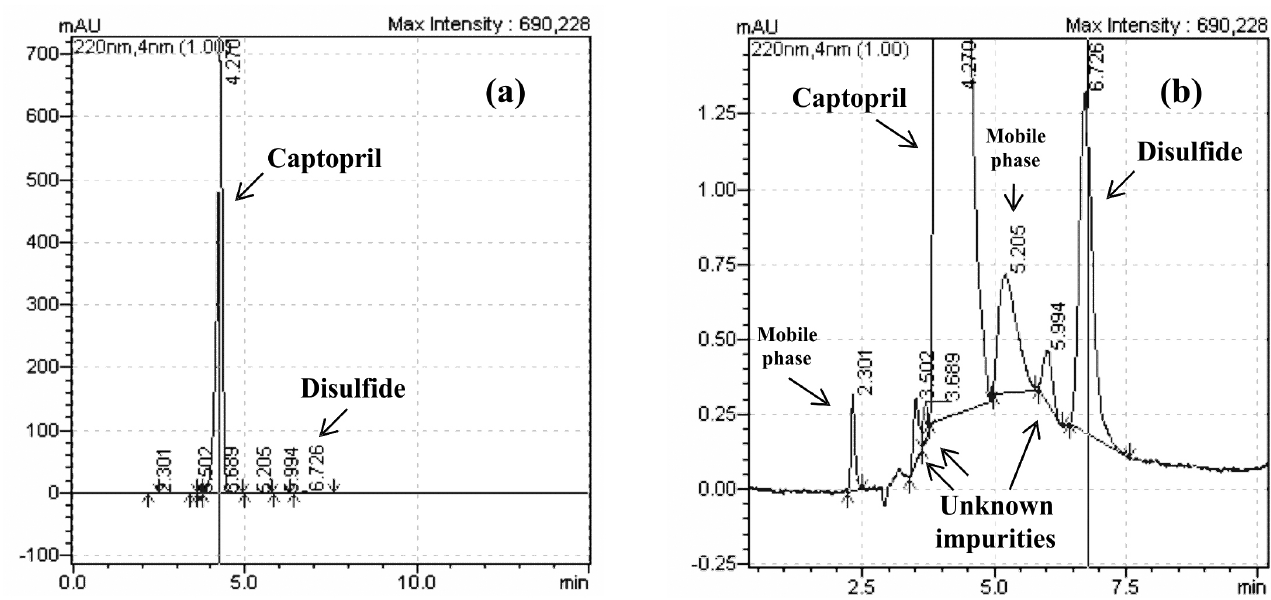
FIGURE 2 - HPLC-DAD chromatogram for captopril CRM (related substances test) (a) and enlargement (b). Experimental conditions: mobile phase methanol - phosphoric acid 0.11% (55:45, v/v), flow-rate 1 ml/min, UV detection at 220 nm, HPLC